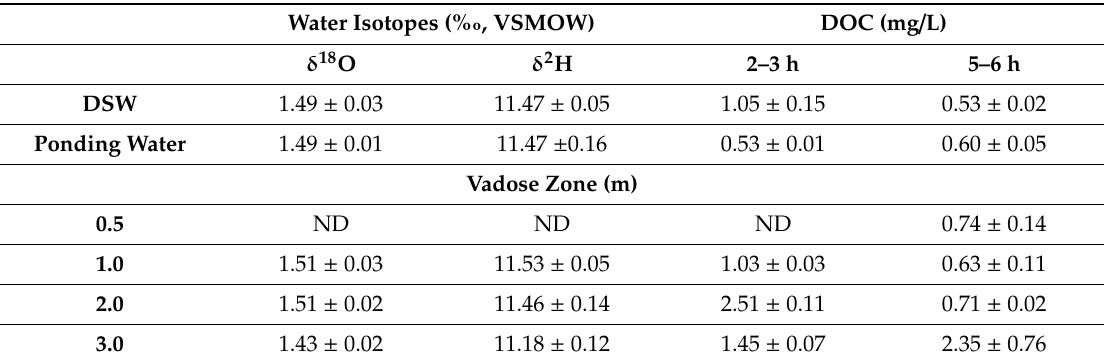
Table 1. Water parameters in the first controlled infiltration experiment with desalinated seawater. Dissolved organic carbon (DOC) and bromide were analyzed for samples collected 2–3 h and 5–6 h after the infiltration began. (ND—no